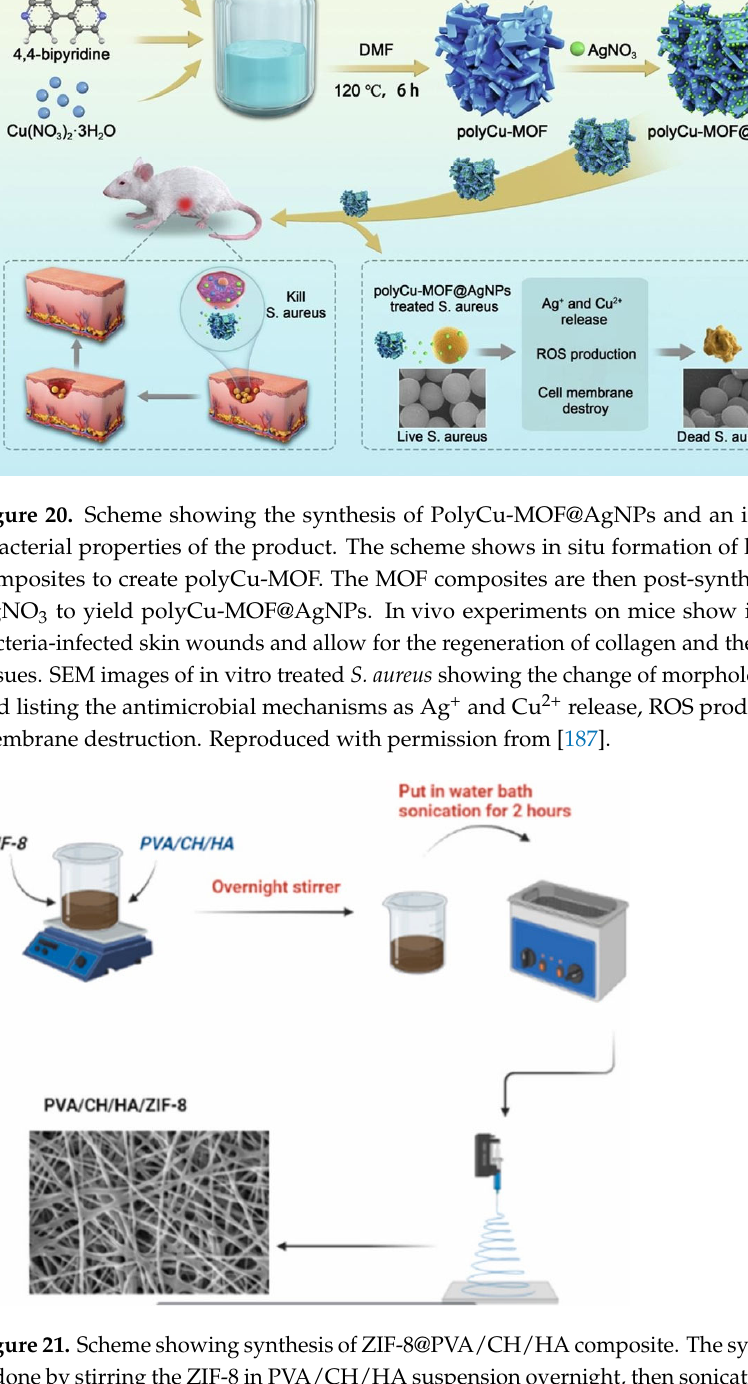
Figure 20. Scheme showing the synthesis of PolyCu ‐ MOF@AgNPs and an illustration of the anti ‐ bacterial properties of the product. The scheme shows in situ formation of loaded MOF/hybrid com ‐ posites to create polyCu ‐ MOF. The MOF composites are then post ‐ synthetically treated with AgNO 3 to yield polyCu ‐ MOF@AgNPs. In vivo experiments on mice show improved healing of bacteria ‐ infected skin wounds and allow for the regeneration of collagen and the healing of damaged tissues. SEM images of in vitro treated S. aureus showing the change of morphology of dead S. aureus and listing the antimicrobial mechanisms as Ag + and Cu 2+ release, ROS production as well as cell mem ‐ brane destruction. Reproduced with permission from [187] .